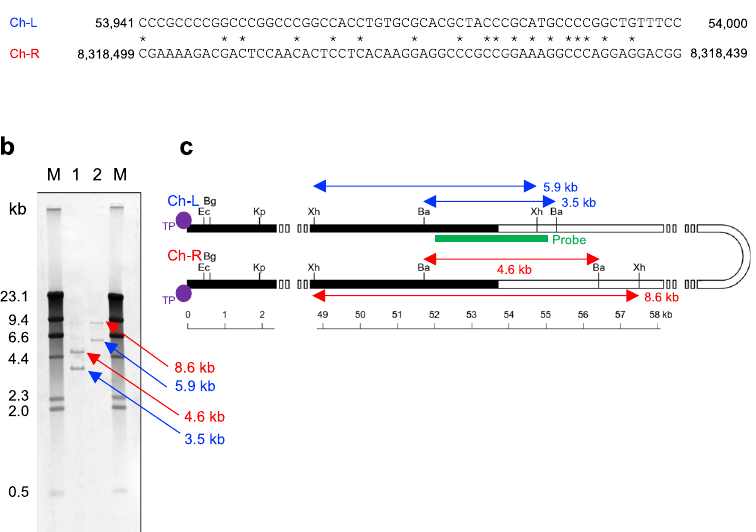
Figure 3. Terminal inverted repeat (TIR) of the S. rochei chromosome. ( a ) Nucleotide sequence comparison of inside ends of the TIR regions. Identical sequences are indicated by asterisks. Ch-L, chromosome left region; Ch-R, chromosome right region. ( b ) Southern hybridization analysis of the TIR regions. PCR fragment harboring nt 52,079–55,053 was used as a DNA probe to distinguish the TIR boundary. λ -DNA digested with Hin dIII was used as a DNA size marker. Lane M, λ / Hin dIII marker; lane 1, S. rochei 7434AN4 total DNA digested with Bam HI; lane 2, S. rochei 7434AN4 total DNA digested with Xho I. ( c ) Restriction map of the left and right TIR regions of the S. rochei 7434AN4 chromosome. TIR regions of the chromosome are shown by thick black lines. Terminal proteins attached to the 5 ′ -ends are indicated by filled circles. Some important restriction sites are indicated. Bg, Bgl II; Ba, Bam HI; Xh, Xho I; Ec, Eco RI; Kp, Kpn